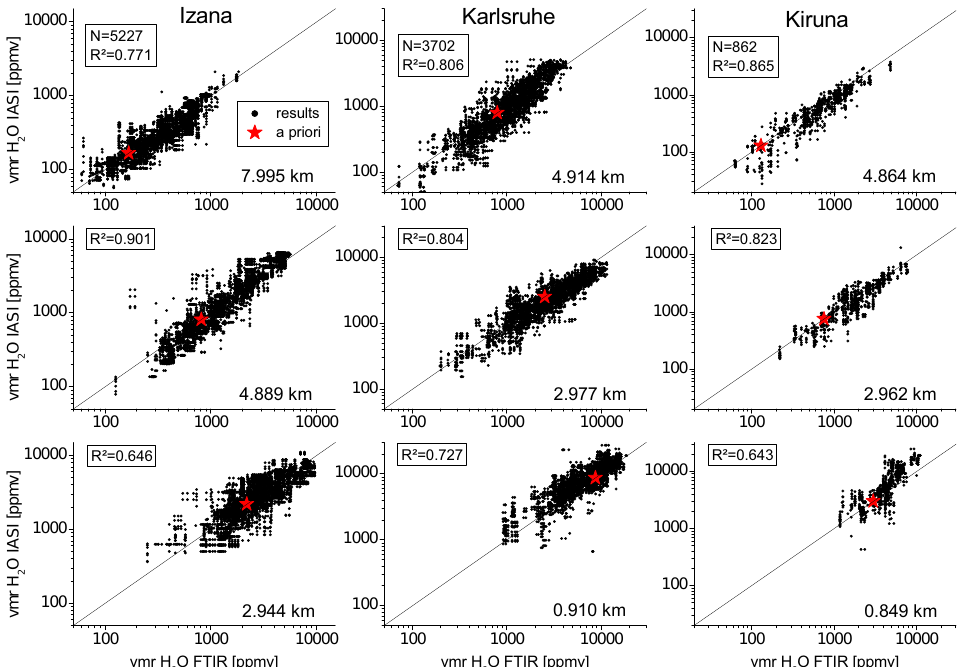
Figure 7. Correlation between the FTIR and IASI H 2 O profile data (product type 1) for three different altitudes and the three locations. The chosen levels depend on the altitude range of best comparability (Fig. 6). The a priori mixing ratios are denoted by red stars and the 1-to-1 diagonal is indicated as a black line.